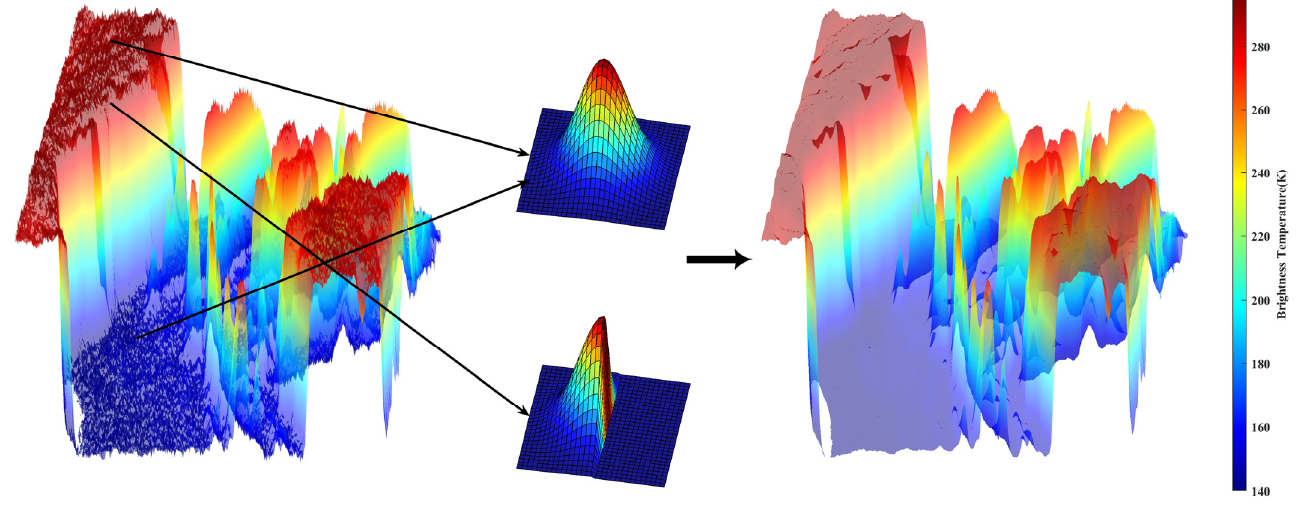
Figure 4. Illustration of the Bilateral Filter’s denoising operation in an actual MWRI scenario. (In the center of the figure is the performance of the spatial-variant Bilateral Filter at different geolocation positions).